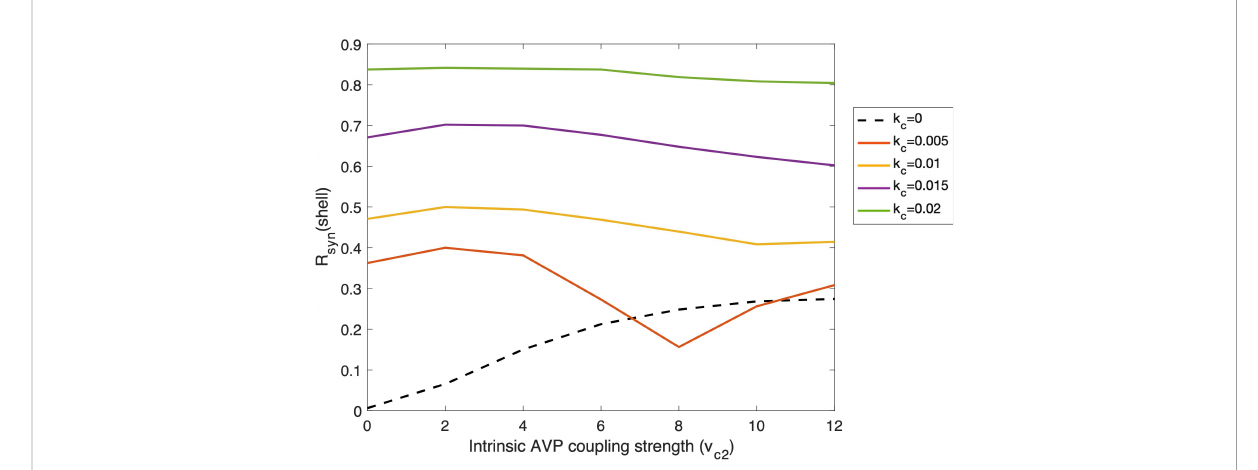
FIGURE 7 Changes of degree of synchronization within the shell as functions of intra-subpopulation coupling strength of AVP ( v c 2 ) under the entrainment of VIP signals with different external coupling strength ( k c ). Simulation was conducted with 50 cells in the core and 150 cells in the shell. The probability of the coupling between the core and the shell is 0.5. Dashed line: the shell ensemble only receives AVP coupling signals; Solid lines: the shell ensemble receives both AVP and VIP coupling signals, with VIP coupling strength